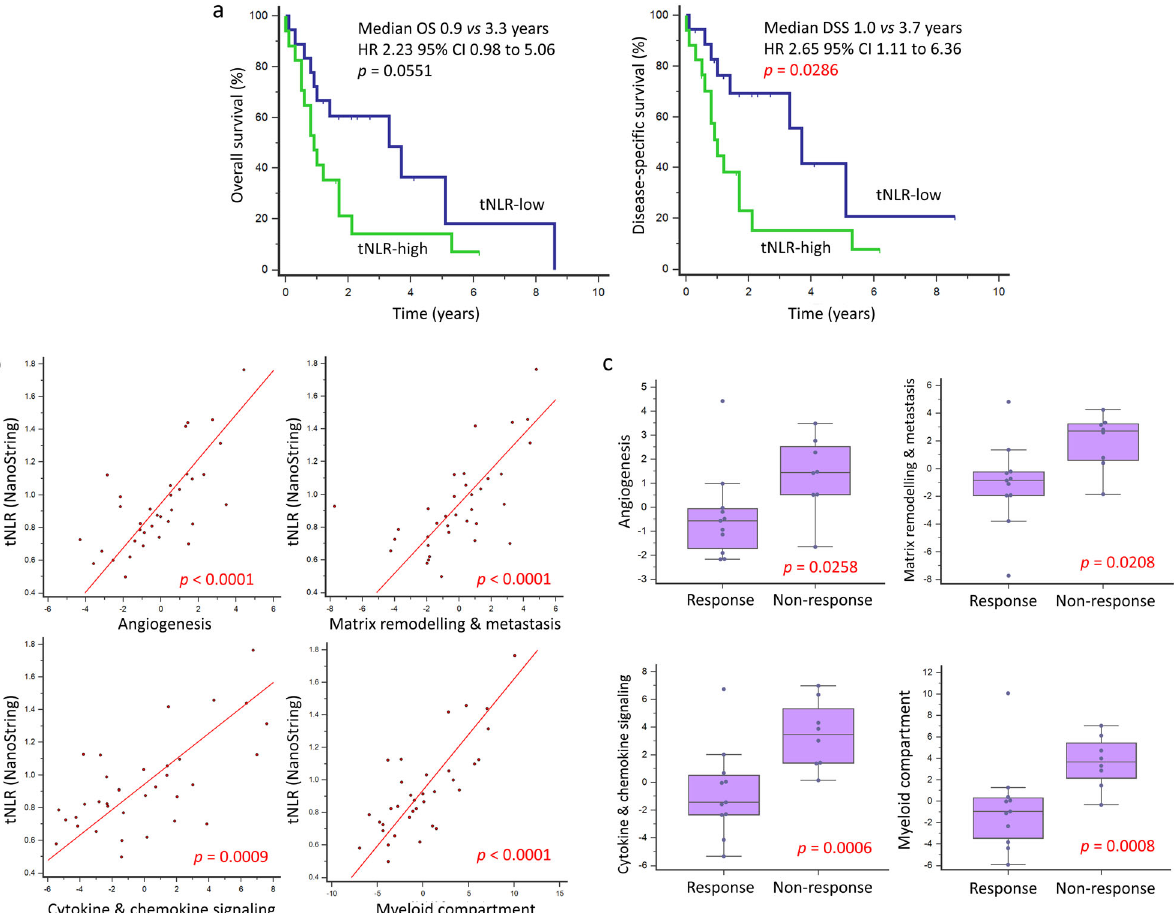
Fig. 6 Correlation of tNLR with oncogenic signaling pathways and survival outcomes. a Similar to peripheral blood NLR, high tNLR scores conferred worse survival outcomes (OS: HR 2.23, 95%CI 0.98 – 5.06, p = 0.0551); DSS: HR 2.65, 95%CI 1.11 – 6.36, p = 0.0286). b tNLR correlated positively with oncogenic pathway scores including angiogenesis (rho = 0.664, p < 0.0001), matrix remodeling and metastasis (rho = 0.666, p < 0.0001), and cytokine and chemokine signaling (rho = 0.538, p = 0.0009), as well as myeloid compartment scores (rho = 0.689, p < 0.0001). c In patients with non-response to fi rst-line palliative chemotherapy (SD or PD), scores for angiogenesis ( p = 0.0258), matrix remodeling and metastasis ( p = 0.0208), cytokine and chemokine signaling ( p = 0.006), and myeloid compartment ( p = 0.008) were all signi fi cantly higher compared to